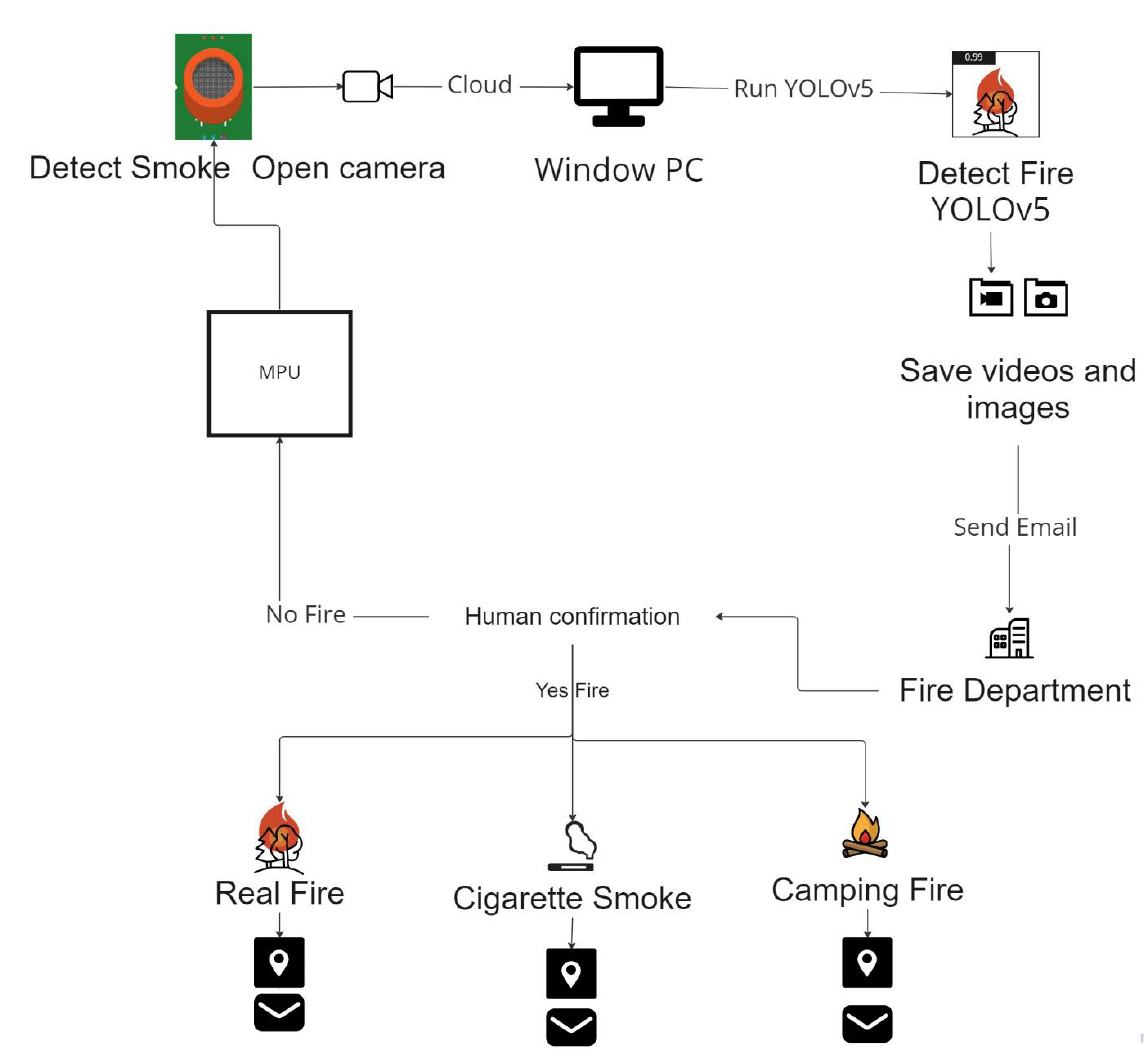
Figure 1. Overall flow chart of the system.